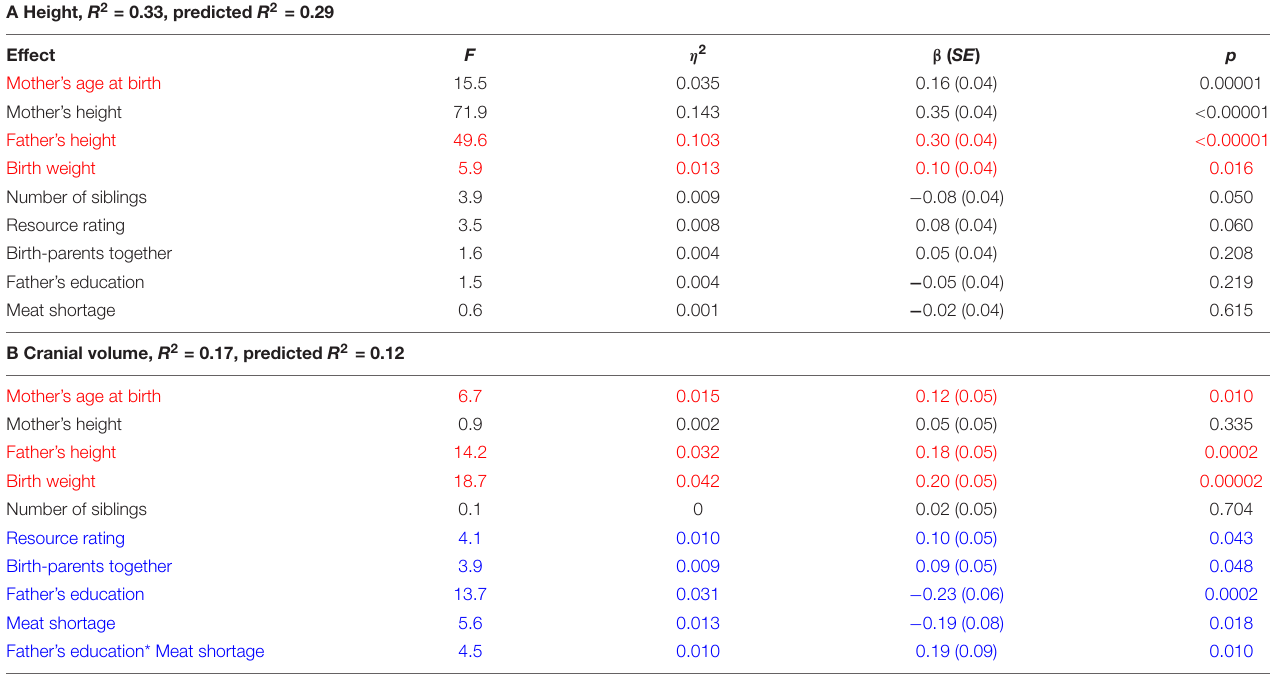
TABLE 2 | Associations between age-adjusted residual height and cranial volume with morphometric and family traits of children and their parents in ANCOVA. A Height, R 2 = 0.33, predicted R 2 =